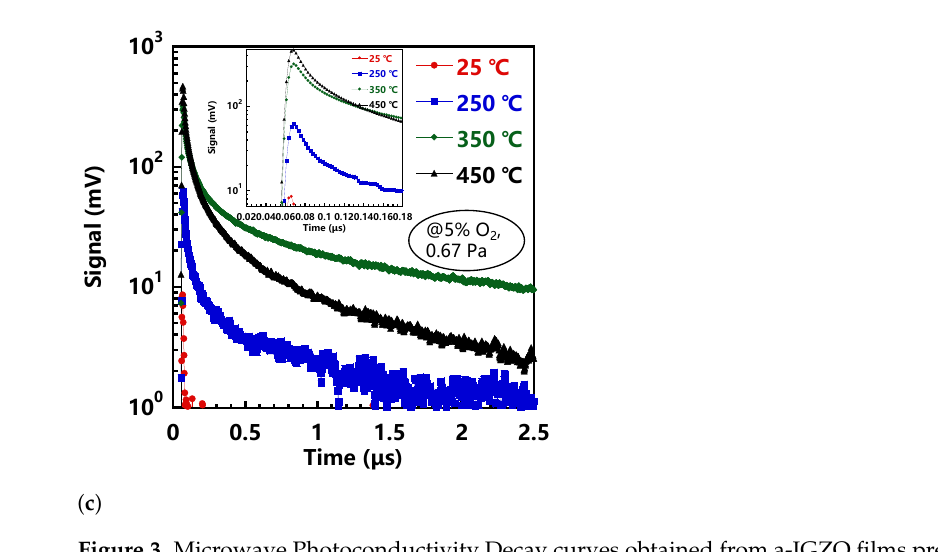
Figure 3. Microwave Photoconductivity Decay curves obtained from a-IGZO films prepared at ( a ) different O 2 /(Ar+O 2 ) ratio(for 0.67 Pa, 450 °C), ( b ) sputtering pressure (for 5% O 2 , 450 °C), and ( c ) annealing temperature (for 5%O 2 , 0.67